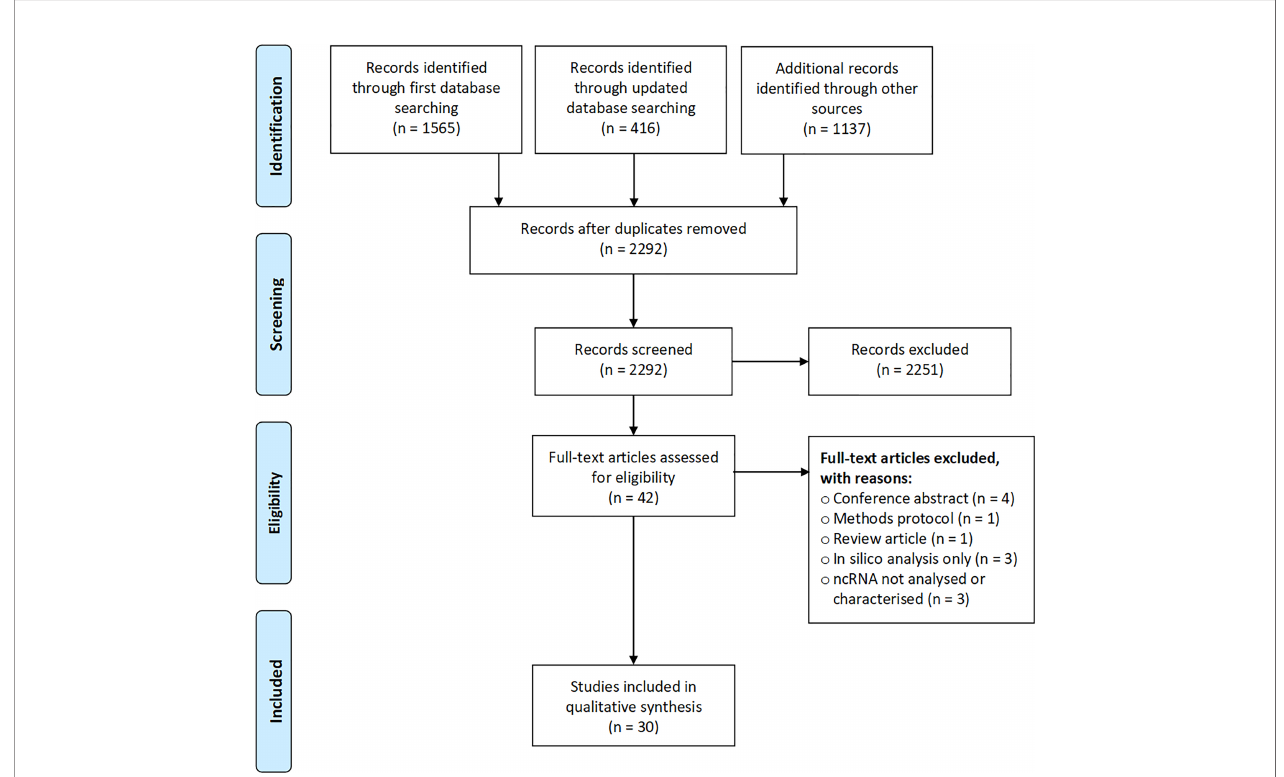
FIGURE 1 | Flow diagram showing stages of study